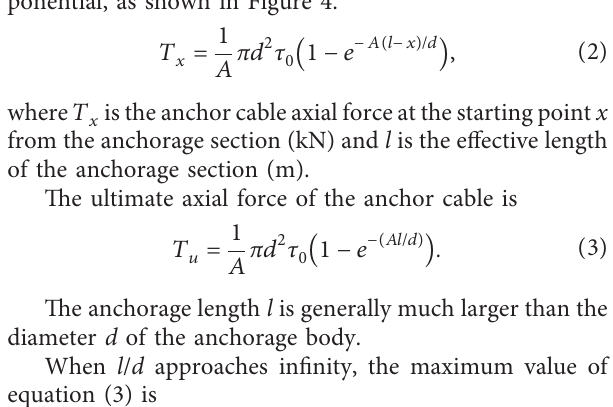
Figure 4: Axial force distribution for exponential